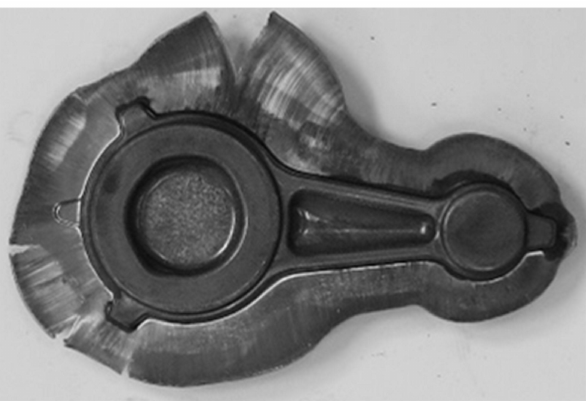
Figure 29. Forgings of connecting rods made of AB-71100 aluminum alloy obtained in the process of forging on a crank press from cast preforms in accordance with variant